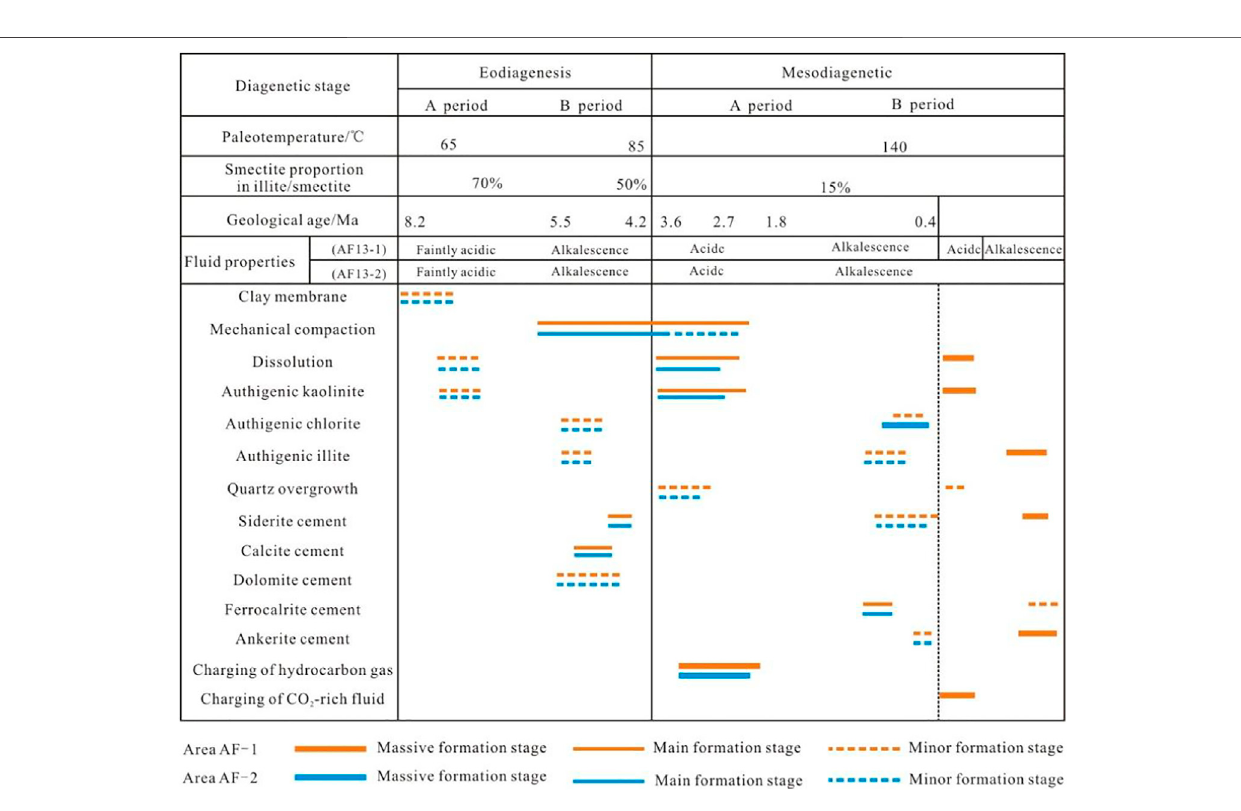
Frontiers in Earth Science |